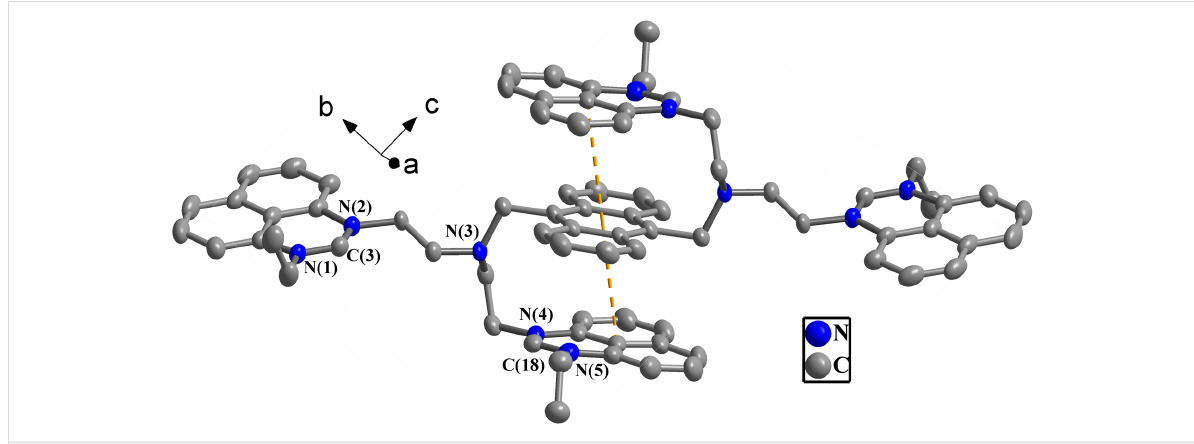
Figure 1: View of the molecular structure of the cationic moiety of 3 in the crystal. Selected bond angles and lengths are N(2)–C(3)–N(1): 125.2(3)°; N(5)–C(18)–N(4): 124.3(4)°; C(3)–N(1): 1.310(5) Å; and C(3)–N(2): 1.315(5) Å.